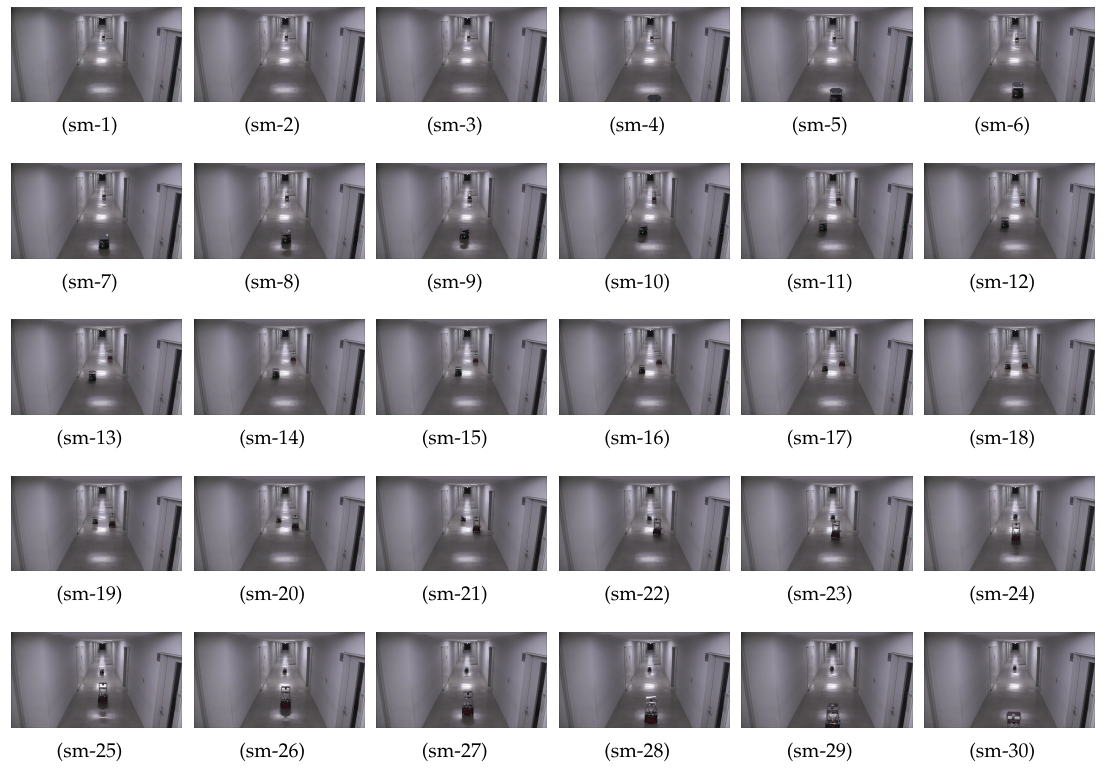
Figure 19. Timely snapshots of ITC based smoothed navigation and collision avoidance. The robot actions at different steps are summarized in Table 7. Please see the supplementary video.